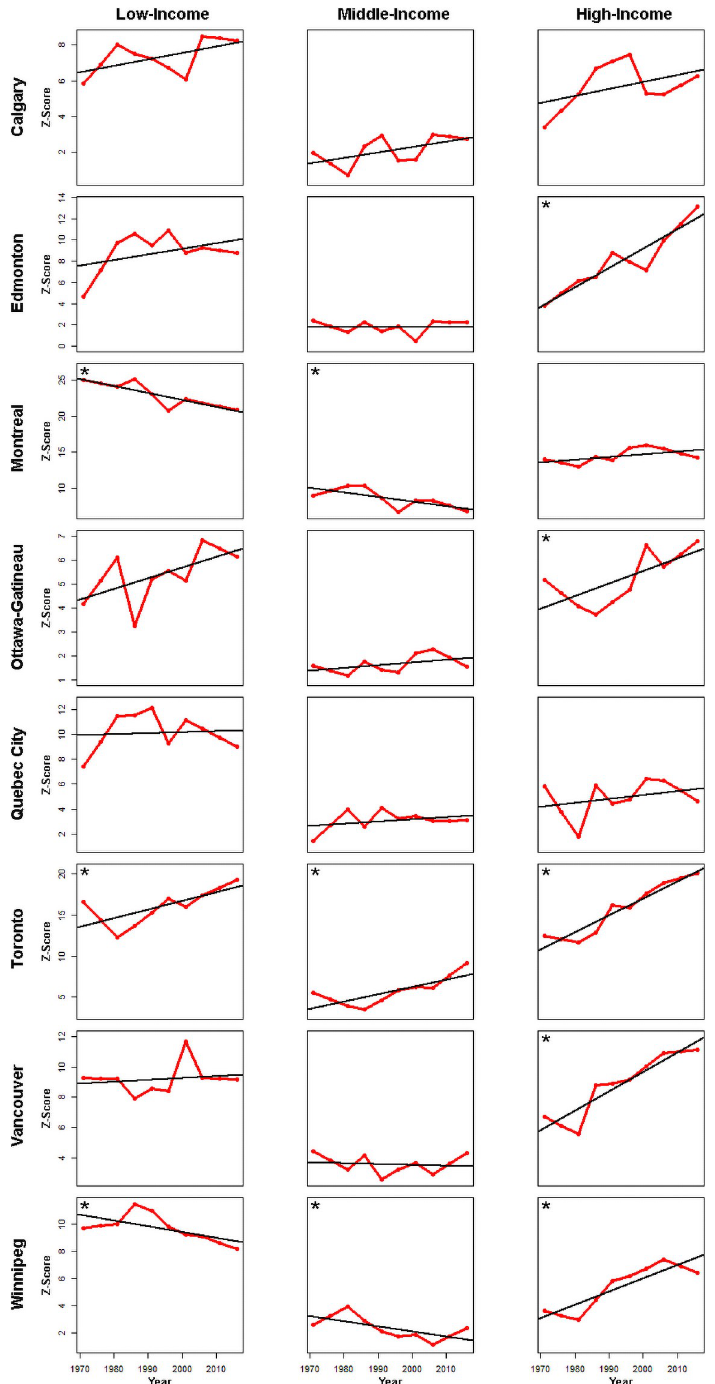
Fig 4. Results of spatial autocorrelation / join count analysis. Confidence intervals from bootstrapping are available in the supplementary material (S9) in S1 Appendix. Significant trends at an α = 0.05 are shown by an � in the upper left corner of a